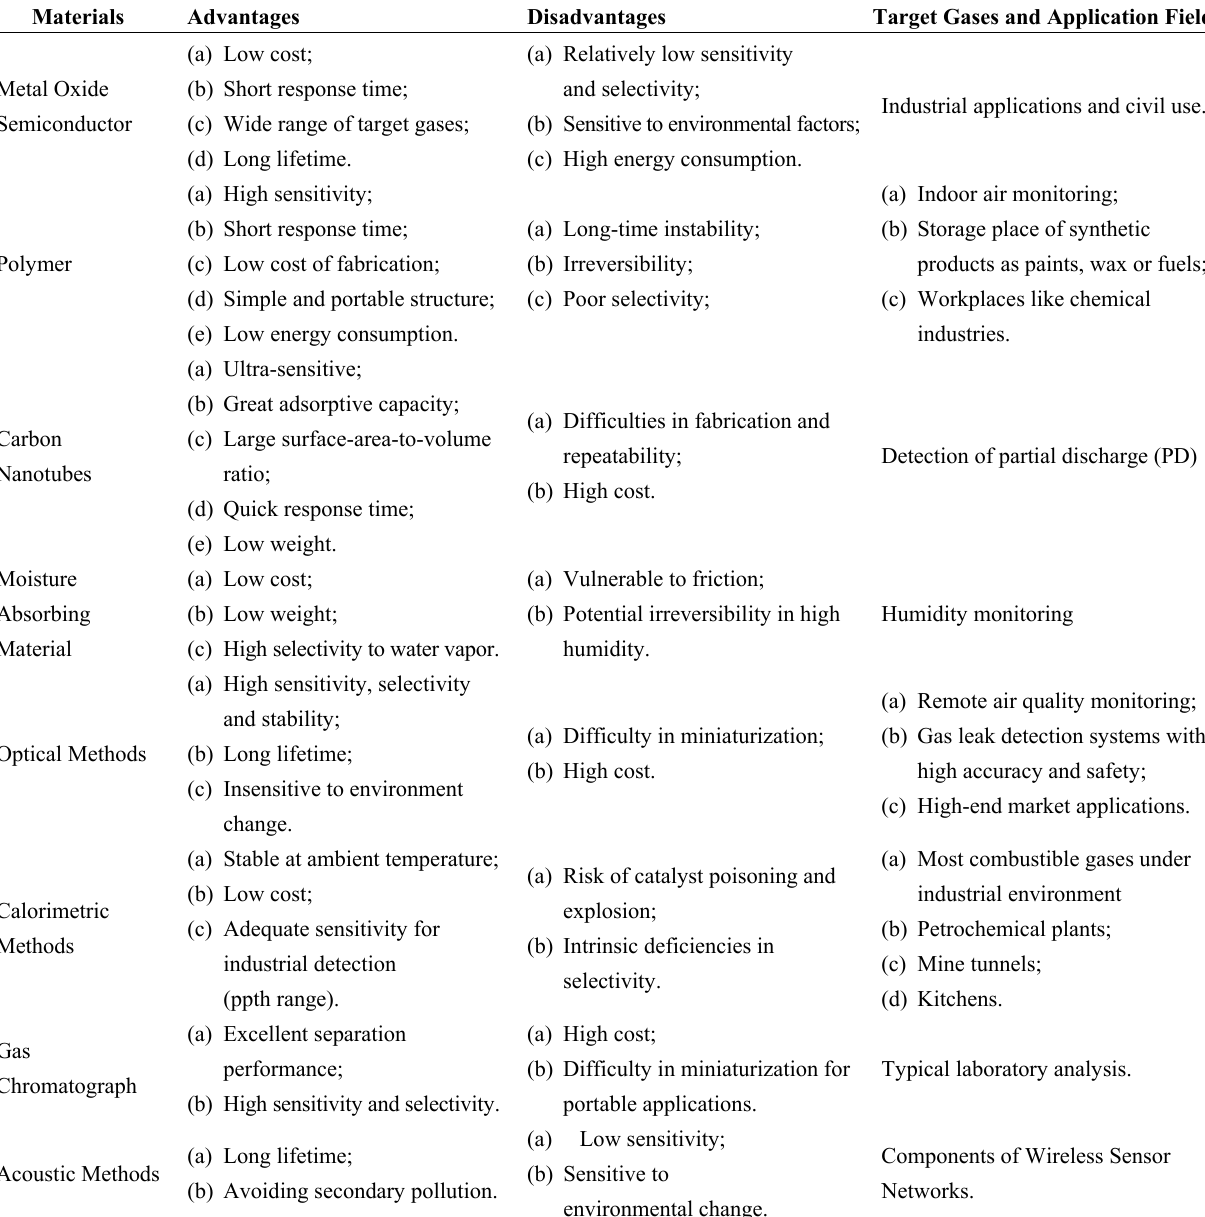
Table 1. Summary of basic gas sensing